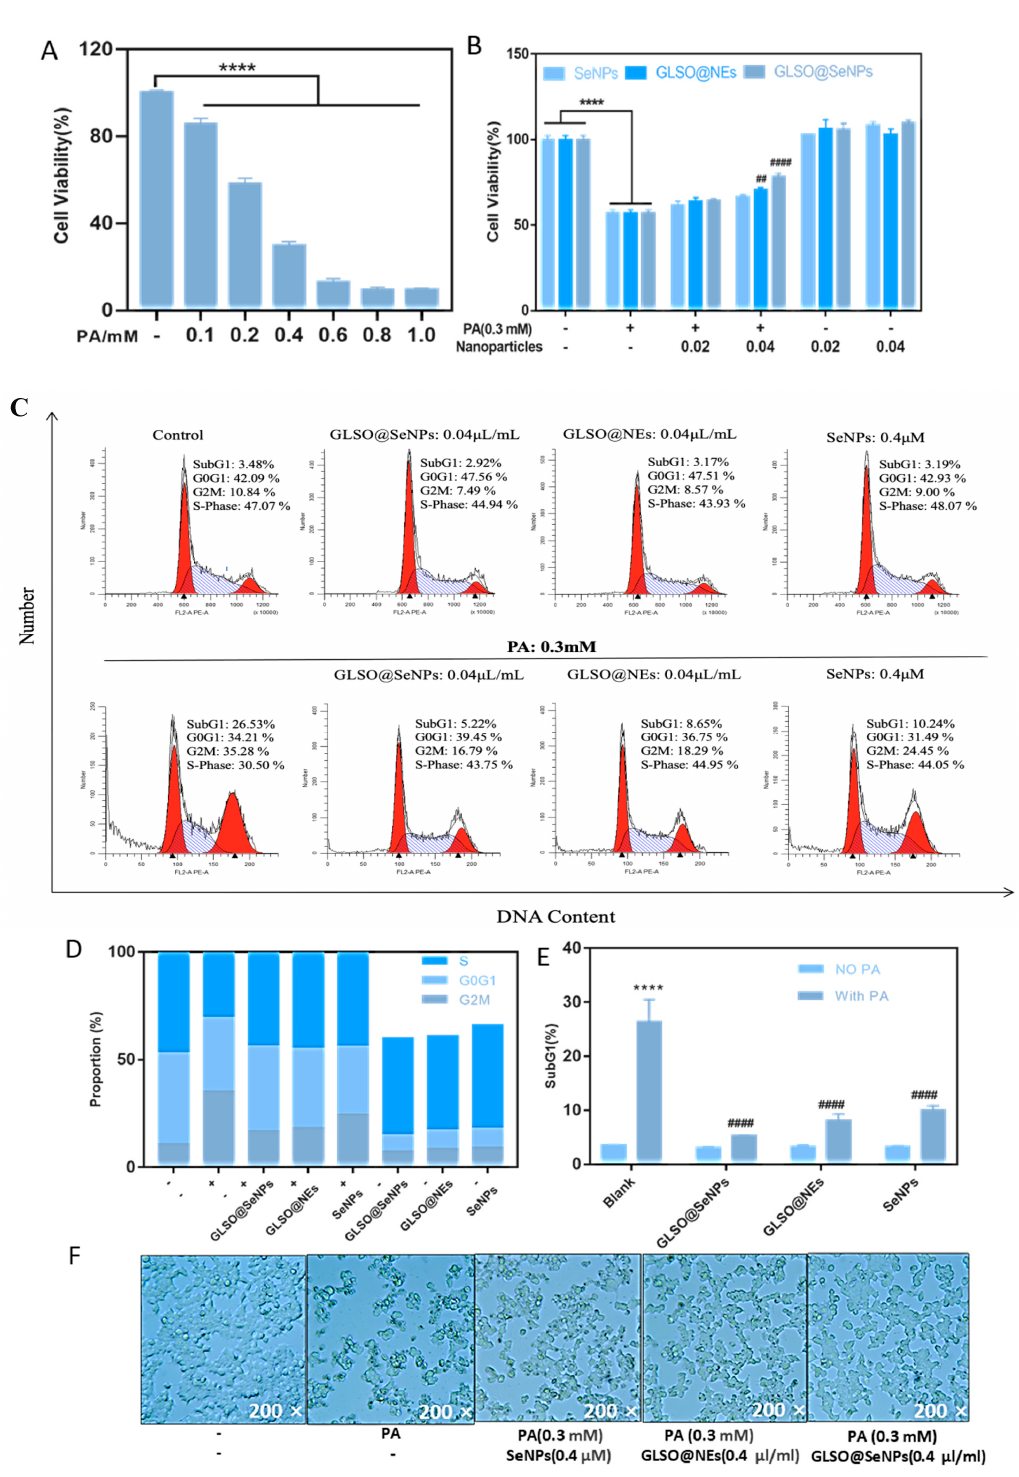
Figure 3. Protective effects of NPs. ( A ) Cell viability after treatment with different concentrations of PA for 24 h. ( B ) The effects of different concentrations of SeNPs, GLSO@NEs, and GLSO@SeNPs on the survival rate of INS-1E cells after 6 h of early intervention followed by PA treatment. ( C ) Modfit software (5.0) was used to analyze the distribution of INS-1E cells in each cycle. ( D ) Quantitative analysis of cell cycle distribution in each group. ( E ) Quantitative analysis of the SubG1 peak in INS-1E cells. (## p < 0.01 means moderate significance, **** (####) p < 0.0001 means the highest significance.) ( F ) Morphology of INS-1E cells treated with different NPs as observed under a microscope (200 ×